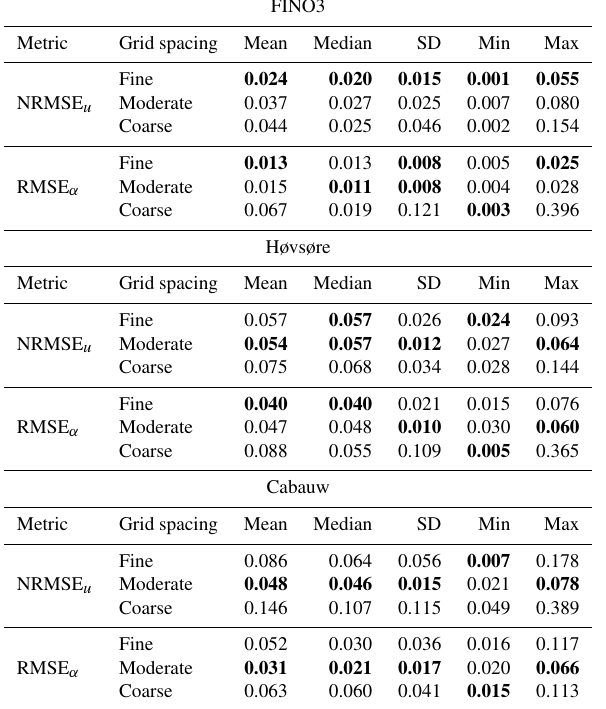
Table 5. Statistics of NRMSE for wind speed (NRMSE u ) and RMSE for wind speed shear exponent (RMSE α ) associated with the groups of PBL schemes across all heights at each site. There are six models in the YSU group, six in the MYJ group, and nine in the Other group. The smallest value for each metric is in bold.